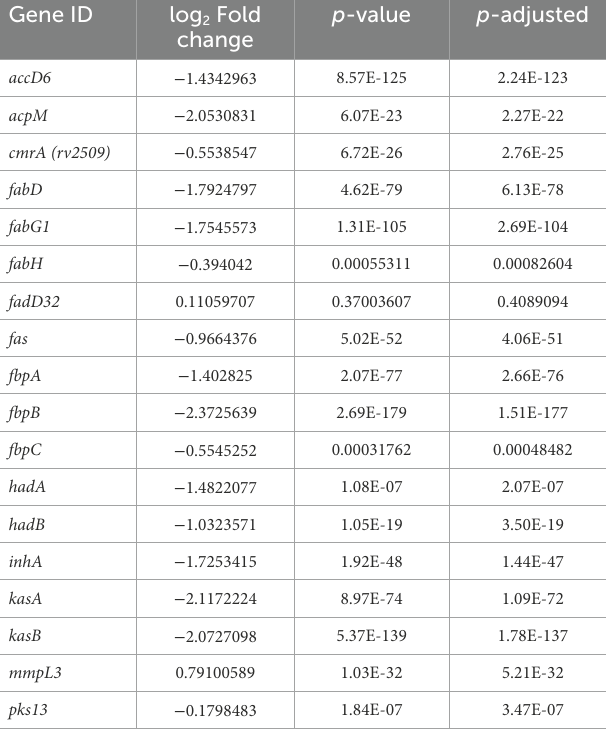
TABLE 2 Gene expression of mycolic acid synthesis pathway – comparing the DMSO control to 30 μ g/ml vanoxerine. Gene ID